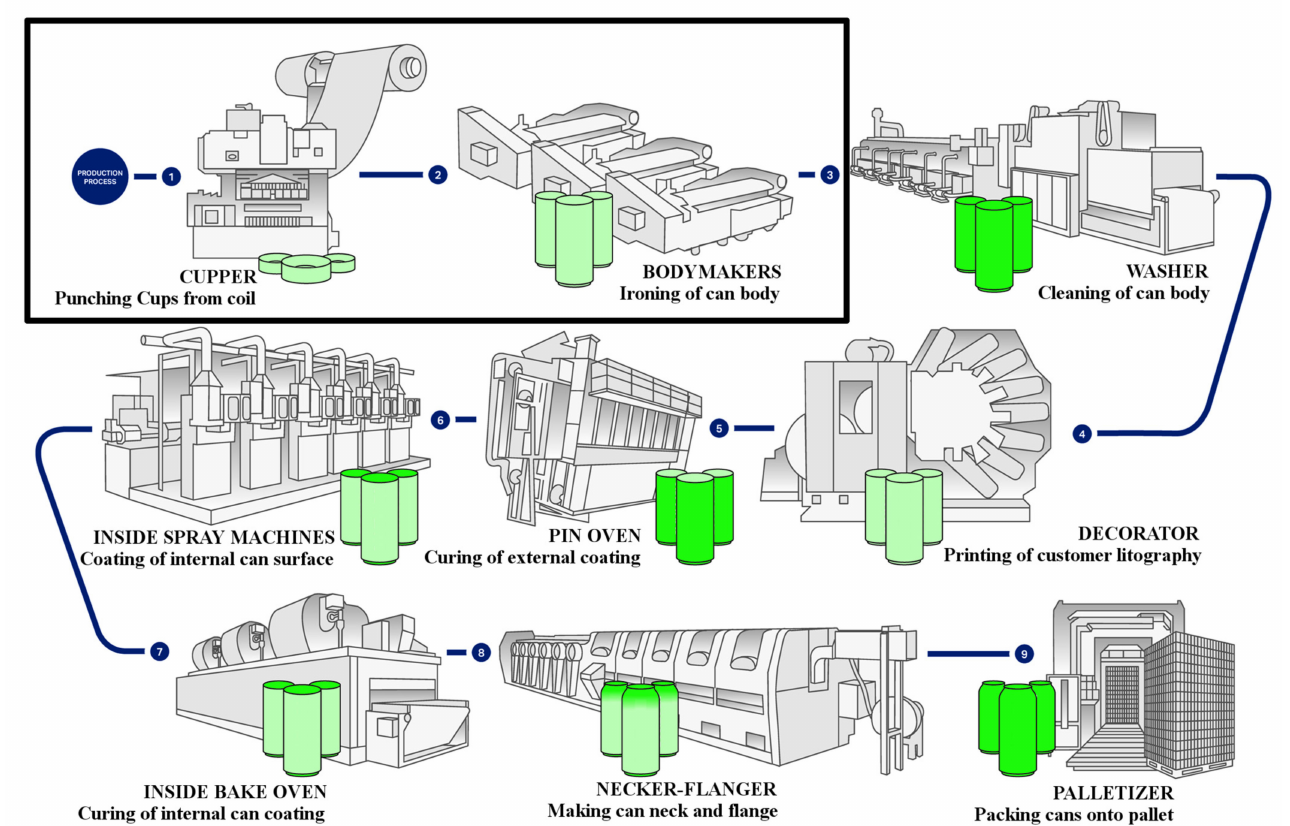
Figure 2. Aluminum beverage can technology process.